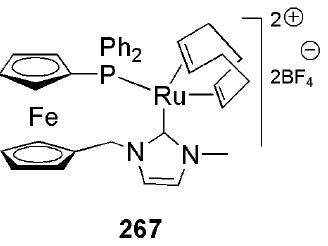
Figure 30. Ruthenium complex of redox ‐ active ferrocenyl phosphine ‐ NHC ligand [217].